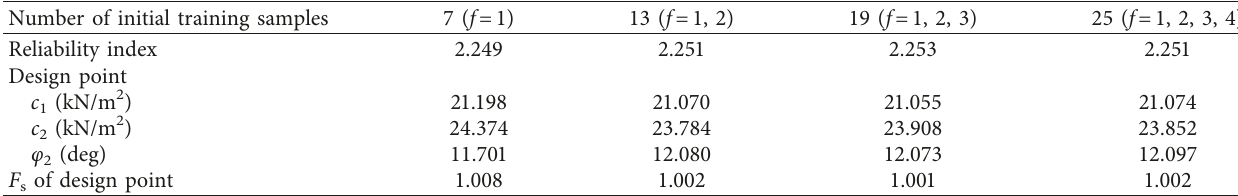
Table 7: Results of probabilistic analysis by the Bishop method for Example 2.